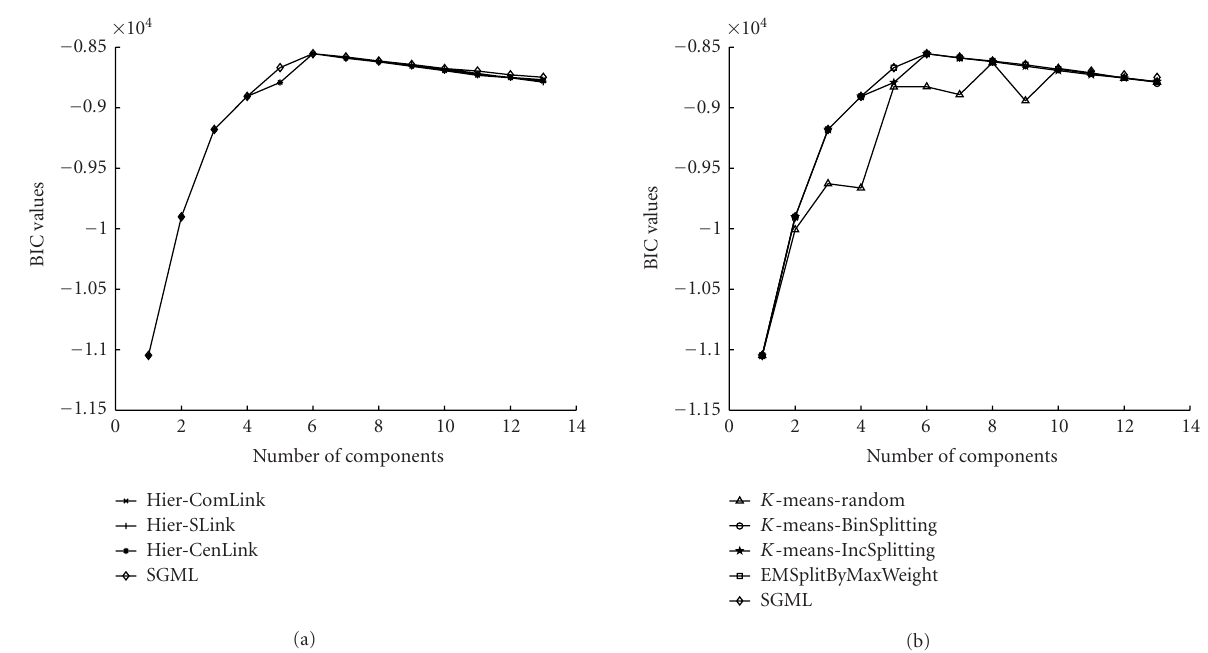
Figure 2: The learning curves of applying various methods in the synthetic data to learn full covariance GMMs.